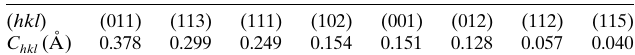
Table 11 Magnitudes of C hkl in pyrite [FeS 2 , space group type Fm (cid:4) 33 m , the structure is reported by Ramsdell (1925)].